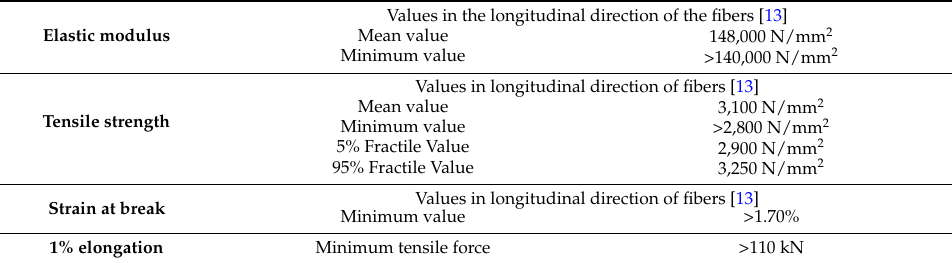
Table 2. Mechanical properties of CFRP rebars according to catalogue.